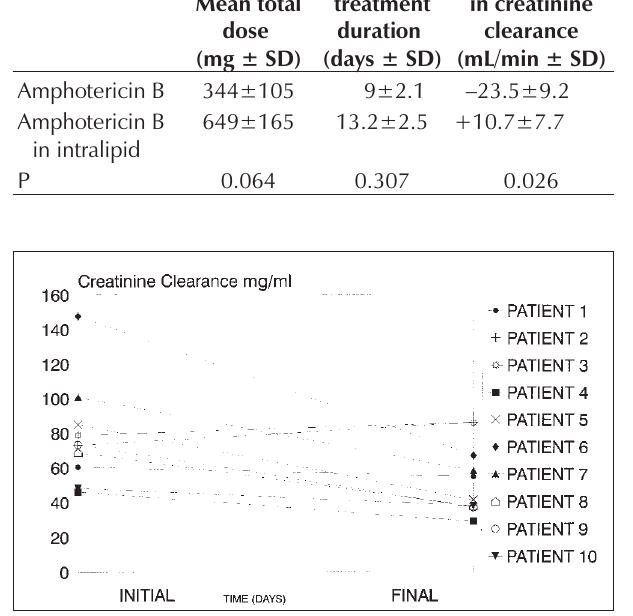
Figure 1) Baseline and ending creatinine clearance values for patients treated with aqueous amphotercin B. Creatinine clearance was calcu- lated using the Cockcroft and Gault formula